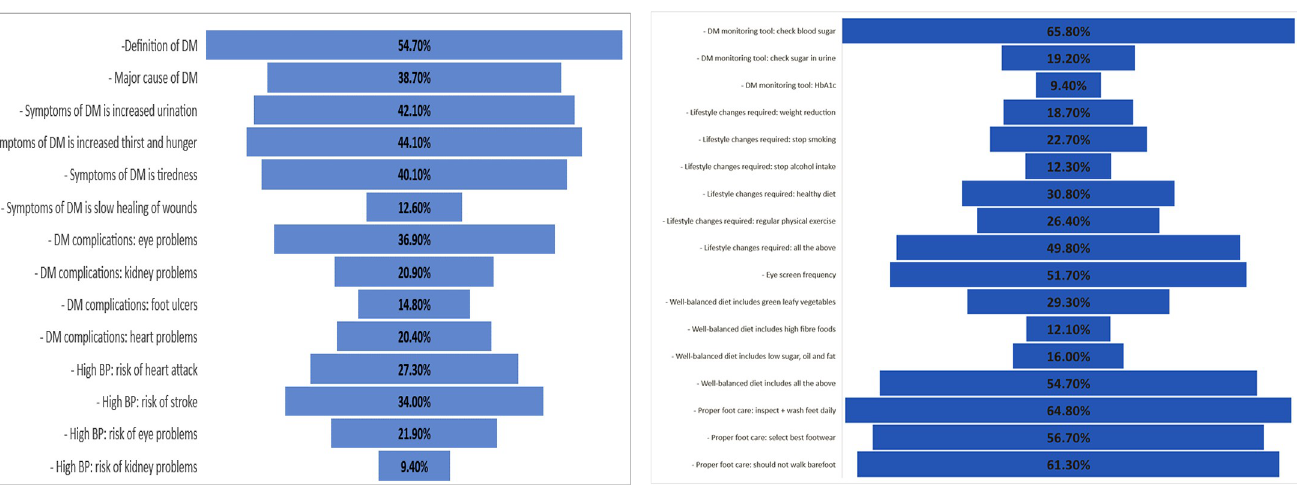
Fig 1. a. Distribution of correct answers to questions on knowledge on symptoms and complications of diabetes and hypertension (n = 406). b Distribution of correct answers to questions on diabetes self-management knowledge (n = 406). https://doi.org/10.1371/journal.pone.0230173.g001 self-management practice score for following a diabetic meal plan, taking care of feet, physical activity, handling participants’ feelings about being diabetic and testing blood sugar, but not for taking medication. Family and/or friend emotional support (nagging, encouraging /reas- suring and handling feelings about being diabetic) were positively associated with knowledge score. Multivariable linear regression analysis (S3 and S4 Tables) showed older age was nega- tively associated with knowledge ( 1 : -1.893, 95% CI-3.754; -0.031) and higher income was positively associated with self-management practice ( 1 : 3.434, 95% CI 0.797; 6.070). There were no significant associations between socio-demographic variables, HbA1c and social sup- port with knowledge or self-management practice.